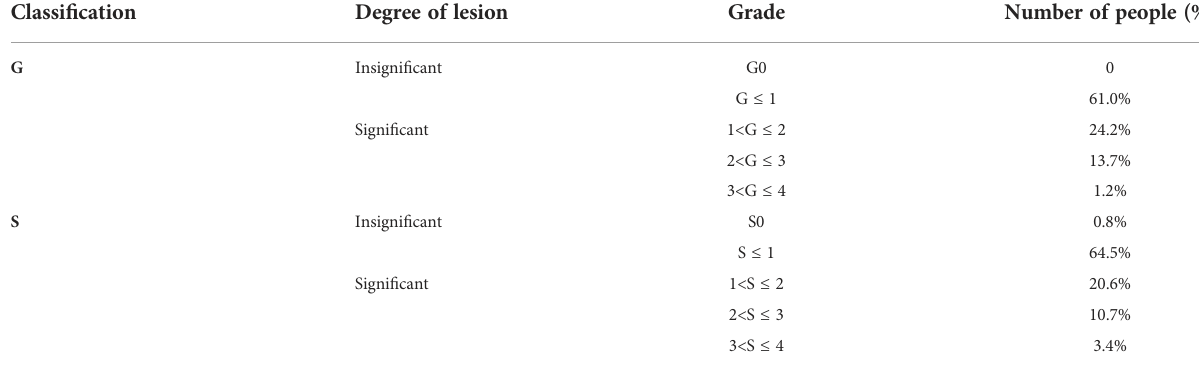
G, in fl ammation grade; S, liver fi brosis